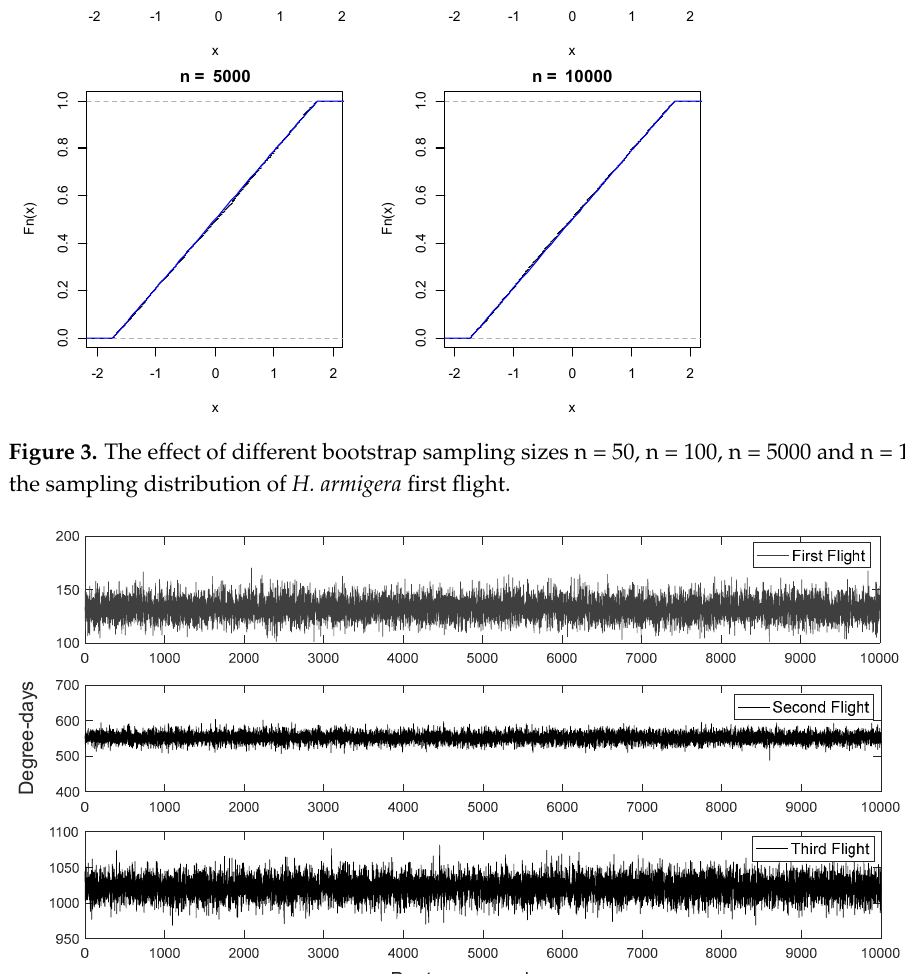
, . . . , ˆ θ ∗ , of random ( 1 ) ( 10,000 )